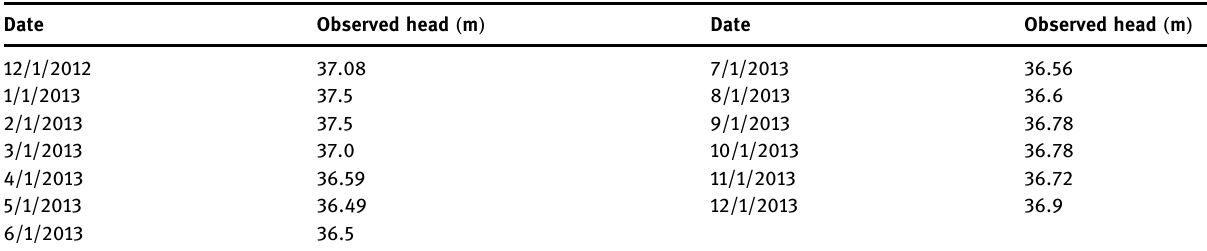
Table 4: Head of the observation well for 1